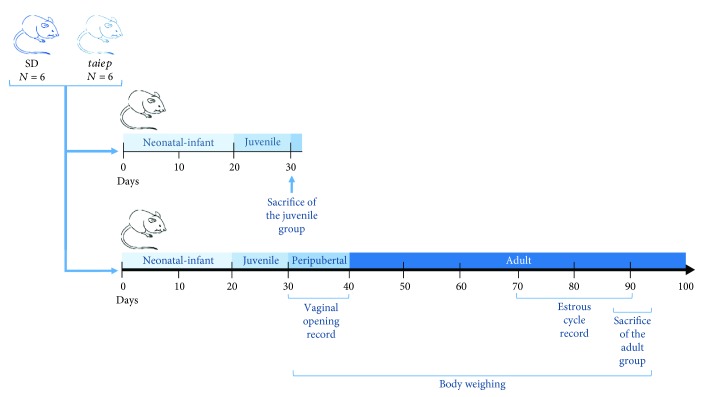
Experimental design. We used 6 taiep rats and 6 Sprague–Dawley (SD) rats divided into two groups: juvenile and adult. The rats in the juvenile group were sacrificed at the age of 30 days and those in the adult group were sacrificed in estrous at the age of 90 ± 5 days. Vaginal opening records, body weighing, and estrous cycle records were acquired in the adult group.